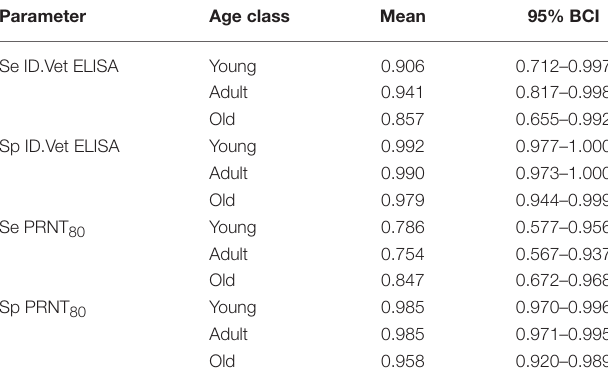
TABLE 2 | No gold standard estimates of the sensitivity (Se) and specificity (Sp) with Bayesian 95% credibility intervals (BCI) for the ID.Vet Rift Valley Fever ELISA at a cut-off of 40 and the in house PRNT80 with a cut-off of 80 estimated separately for each age